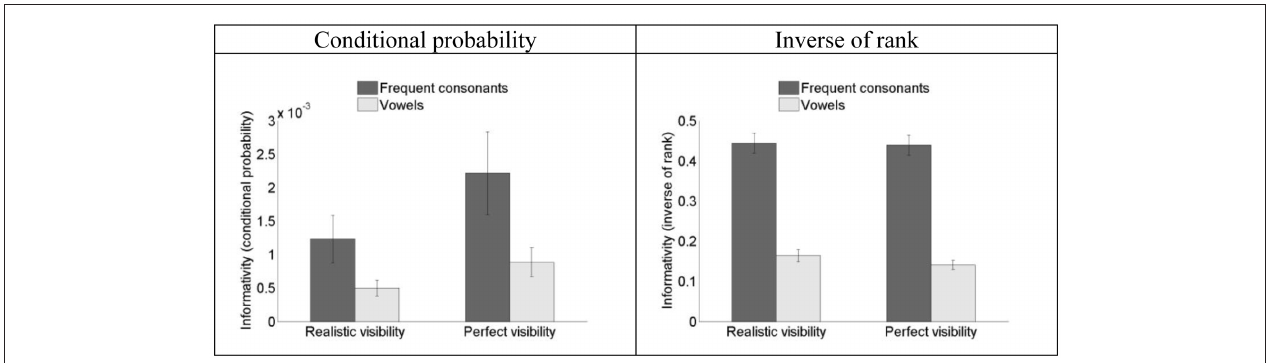
Figure 5 | effect of consonants and vowels in bigram-based analyses. Left: informativeness calculated using an average conditional probability measure. Right: informativeness calculated using the inverse of within-word ranking of conditional